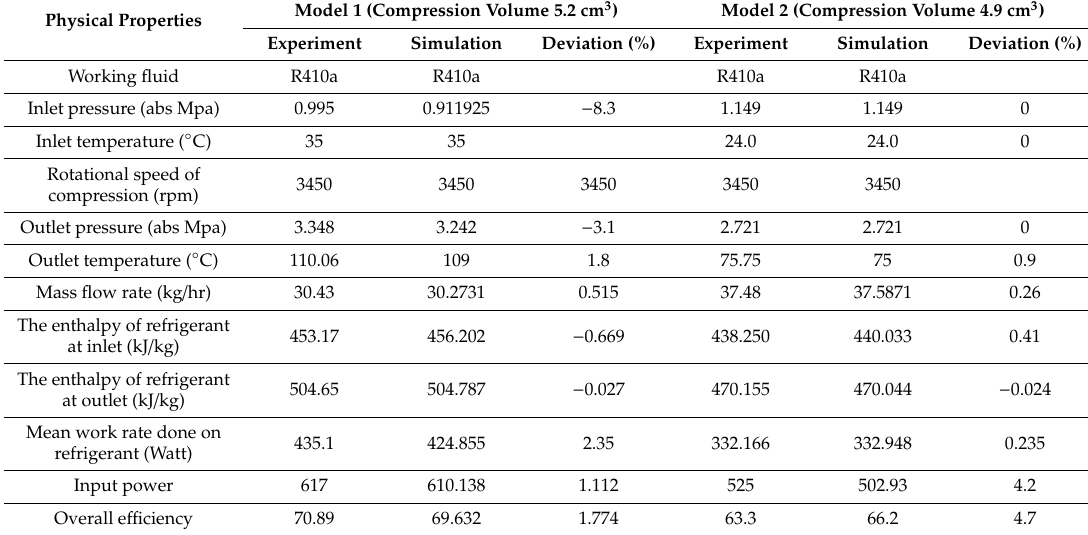
Table 3. The comparison of experimental and numerical